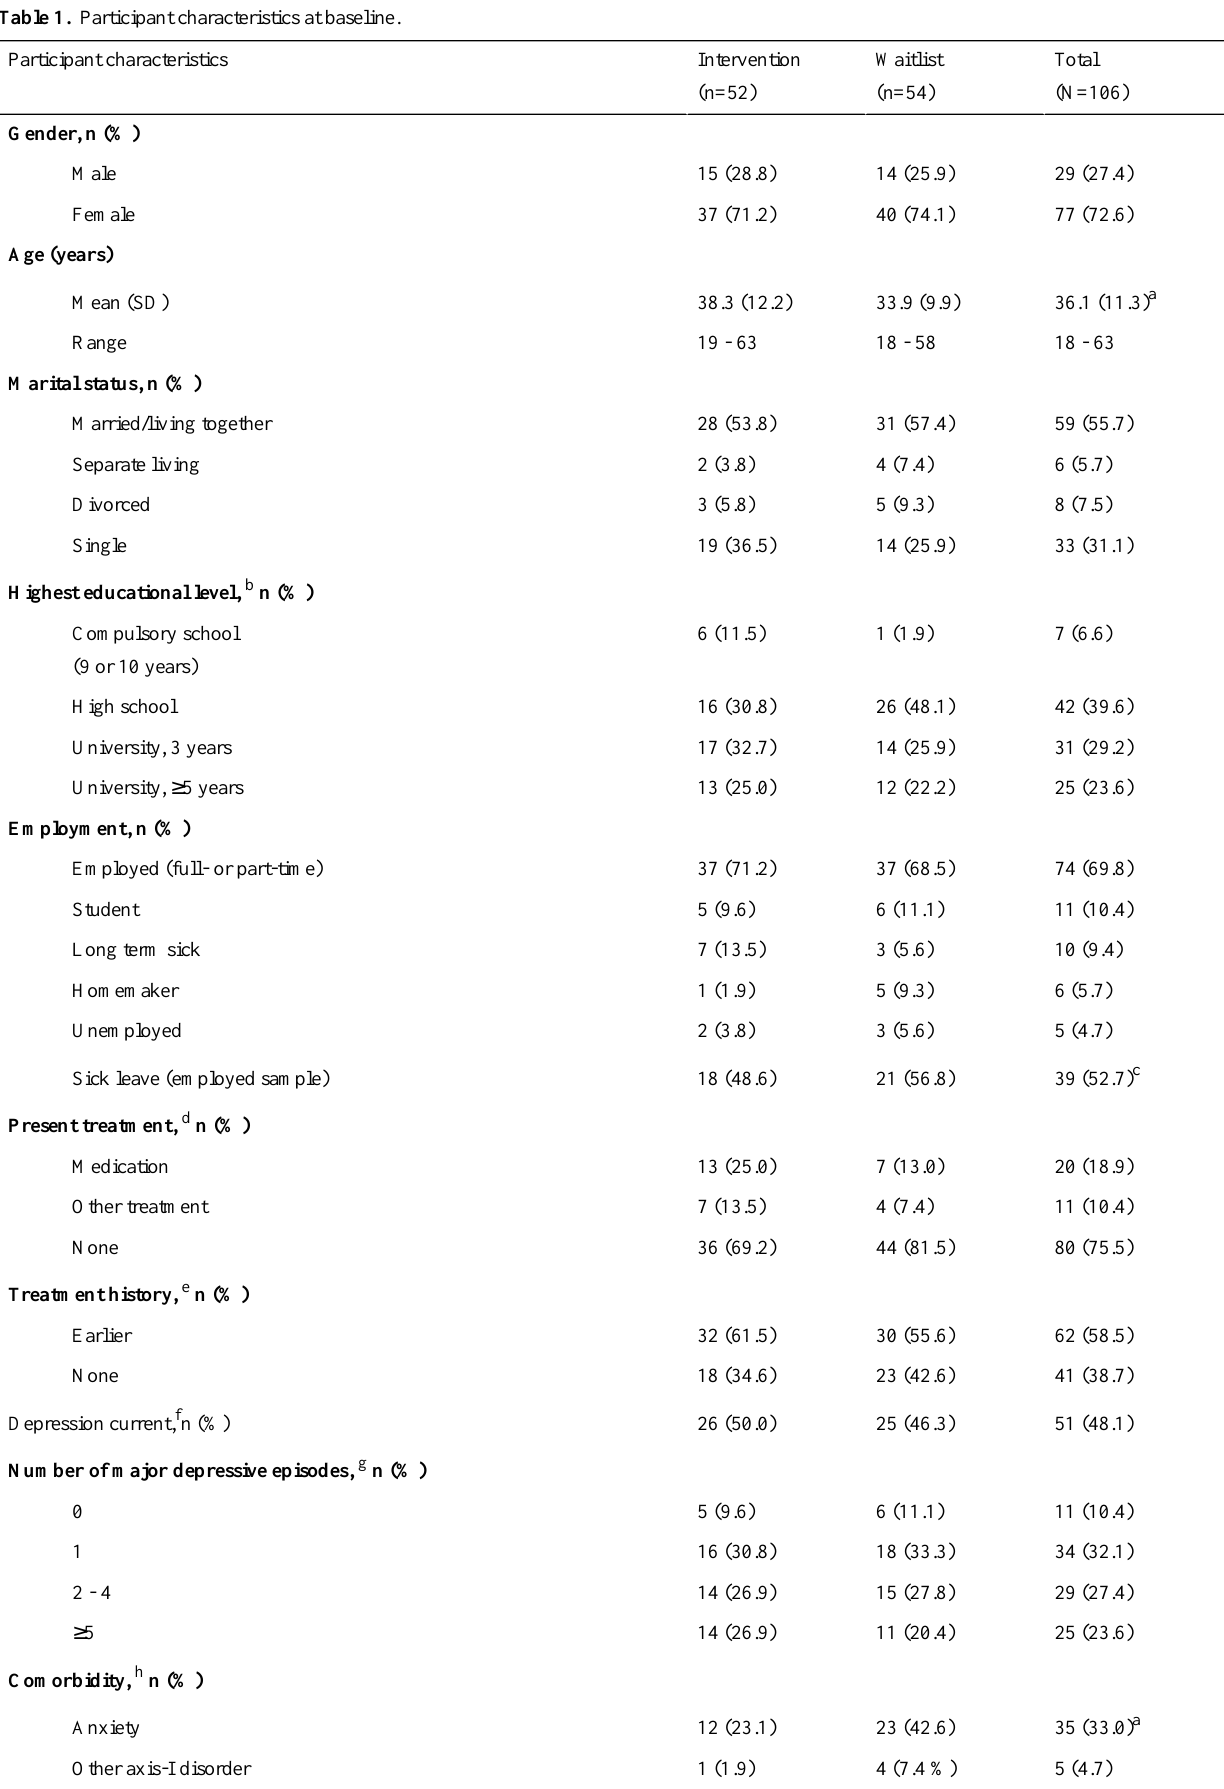
Table 1. Participant characteristics at